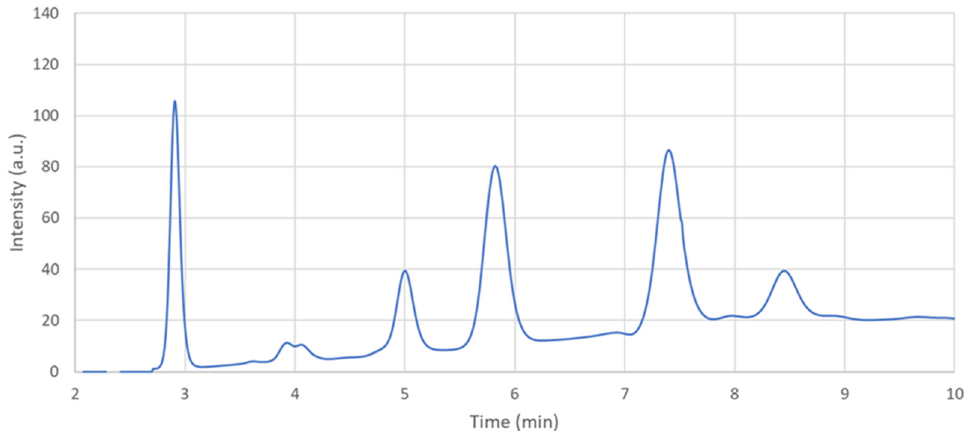
Figure 1. Representative HPAEC-PAD chromatogram of the hydrolyzed carbohydrates from saliva samples. The monitored peaks were the following: fucose (min. 2.9), galactosamine (min. 5.0), glucosamine (min. 5.8), galactose (min. 7.4), glucose (min. 7.9), and mannose (min. 8.4). Samples with a significant glucose peak were discarded because they were hemolyzed.